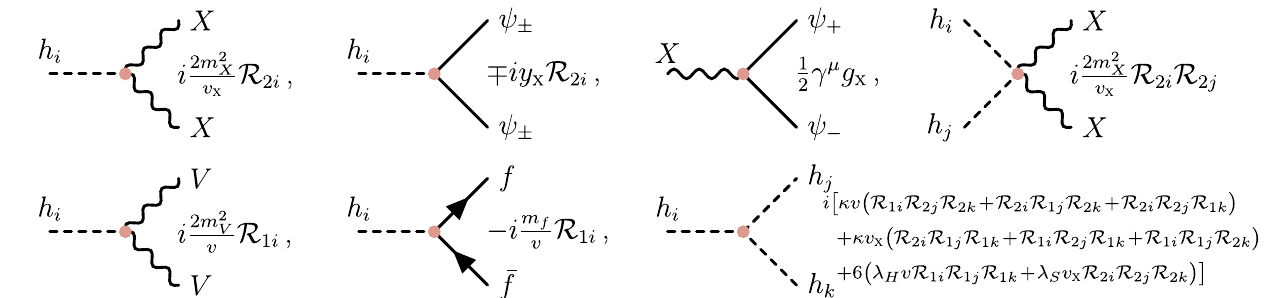
f denotes the SM fermions, and R is the rotation matrix, defined in Eq. (13), where the two scalars h 1 , h 2 mix with mixing angle α